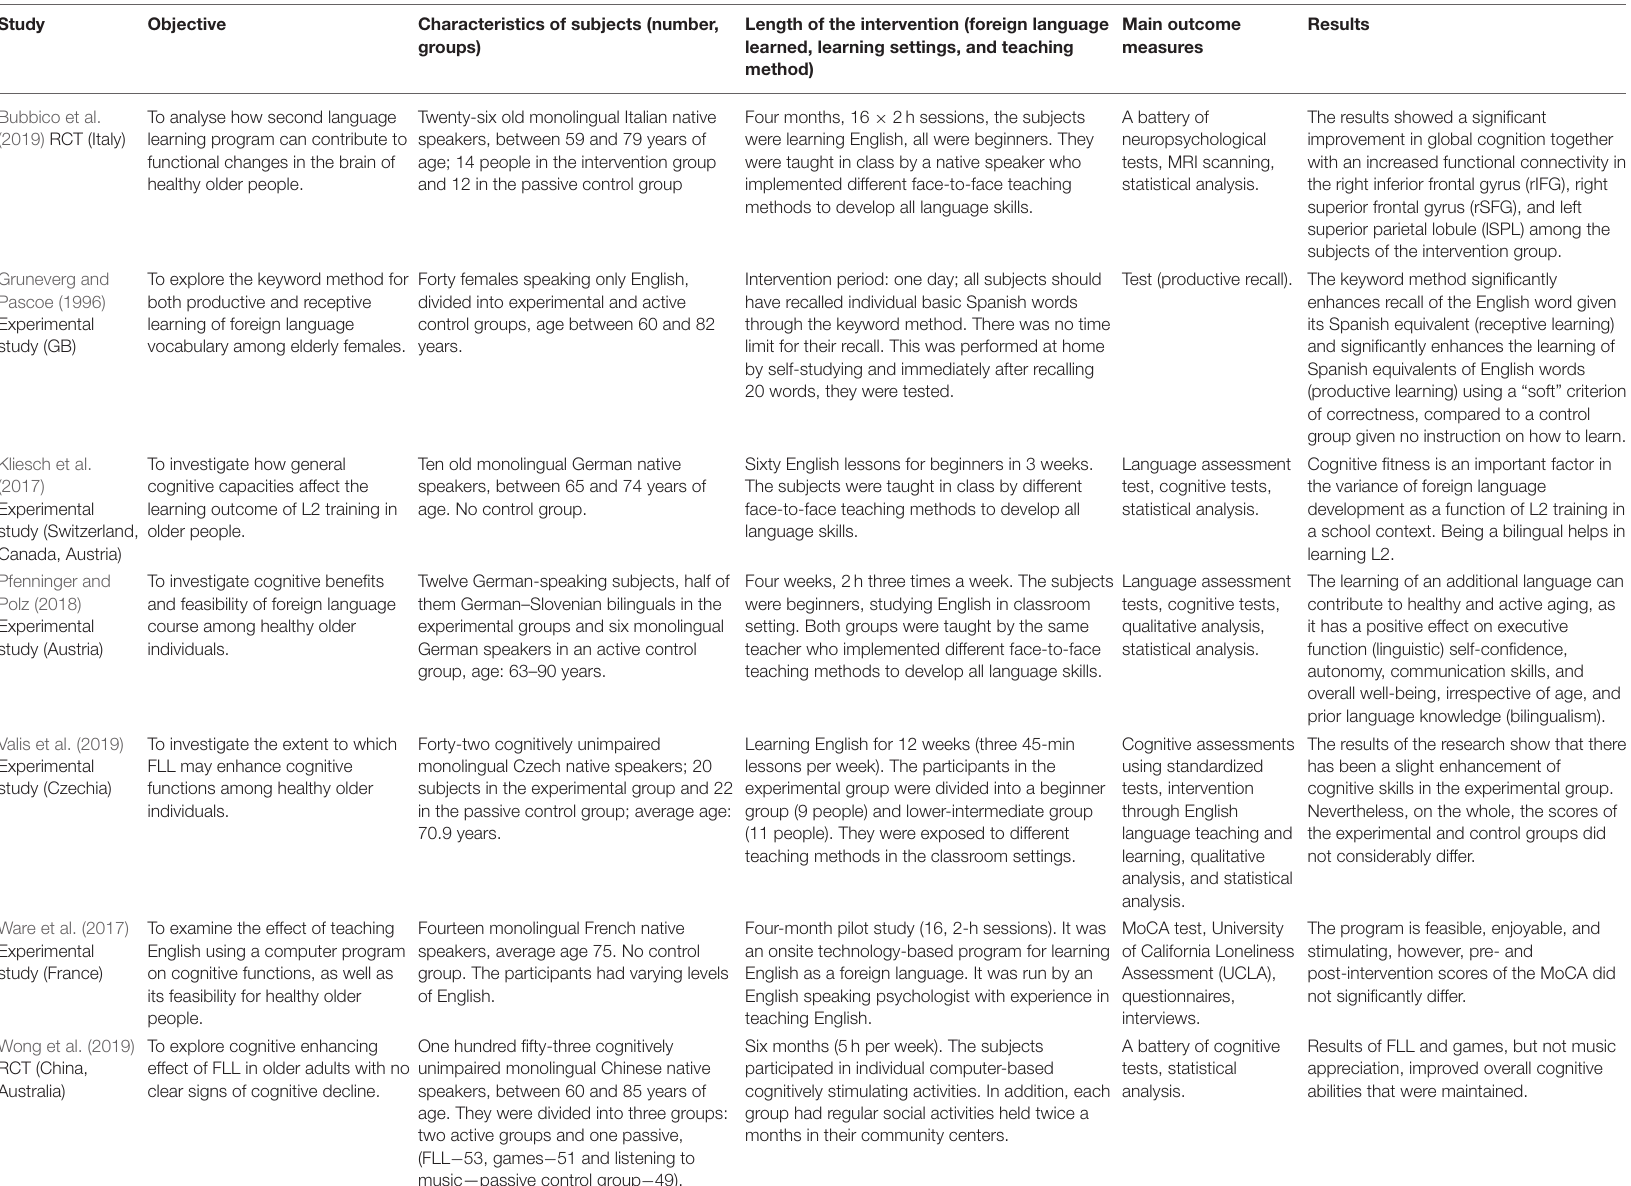
TABLE 1 | An overview of the research studies on the intervention of foreign language learning among healthy older